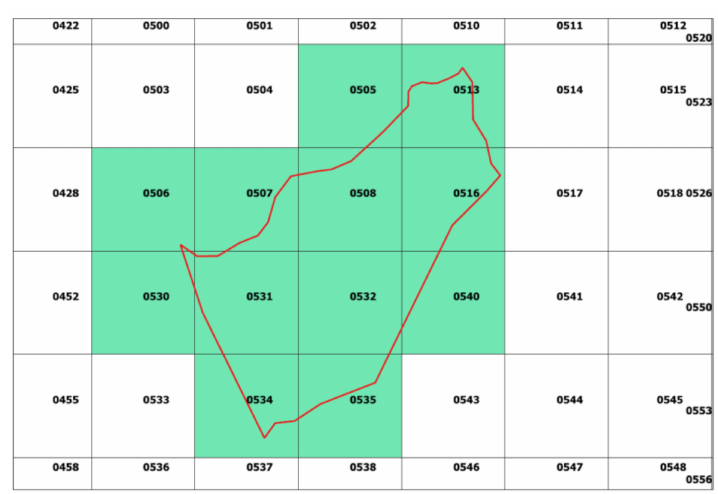
Figure 5. The twelve Tuplekeys that overlap in the Cap Bon